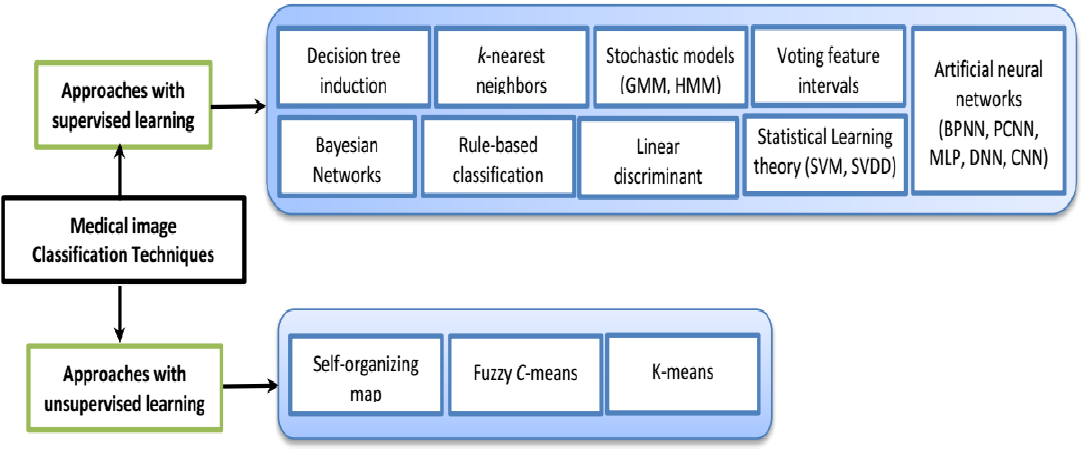
Figure 3. MRI brain images classification methods described in the literature: In this work, the classification methods have been grouped into two categories (green color) according to the type of learning, namely: supervised and unsupervised learning. DNN: Deep neural network, CNN: Convolutional neural network, MLP: multi-layer perceptron, BPNN: Back propagation neural network, PCNN: Pulse-coupled neural network, SVM: Support vector machines, SVDD: Support vector data description, GMM: Gaussian mixture model, HMM: Hidden Markov models.